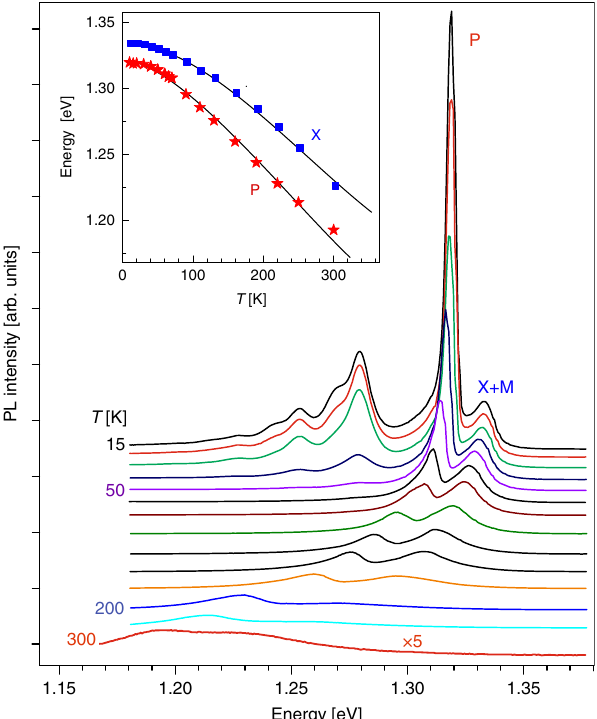
Fig. 3 Temperature dependence of photoluminescence. PL spectra measured at high excitation power in the undoped InSe sample at different temperatures (linear scale). The inset presents the dependencies of the X and P energies vs. temperature